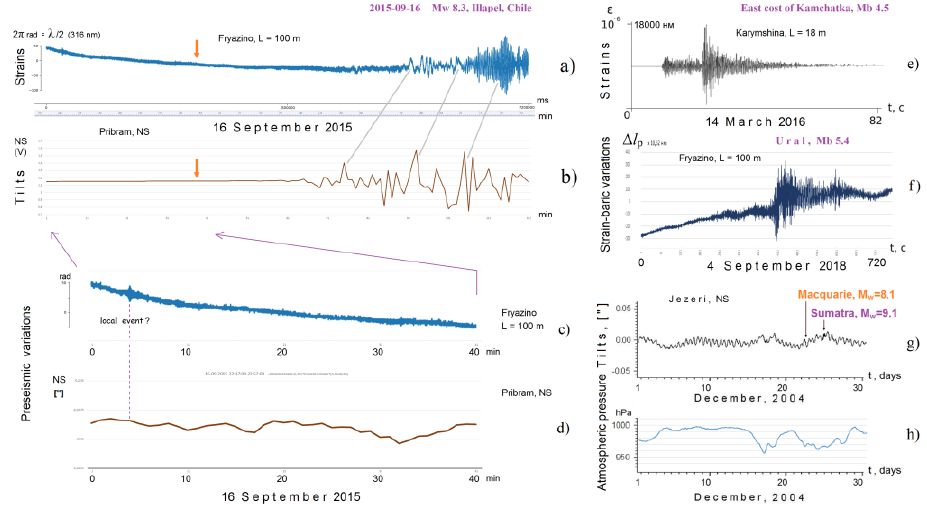
Fig. 2. The examples of strain and tilt registrations: Illapel, Chile Mw 8.3 earthquake on 16 Sep 2015 recorded at FRZ (a, c) and PRB (b, d) observational point; east coast of Kamchatka Mb 4.5 earthquake on 14 Mar 2016 recorded at KRM point (e); Ural Mb 5.4 earthquake on 4 Sep 2018 recorded at FRZ point (f); strain-baric variation at JZR point in December 2004 (g, h).